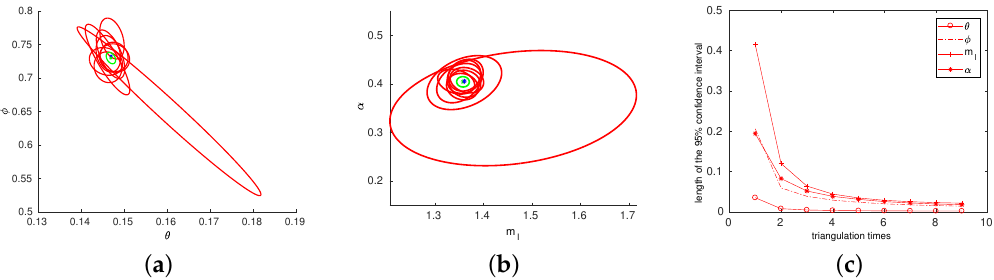
Figure 9. Uncertainty fusion by multiple triangulations. ( a ) Red ellipses denote uncertainty estimated by each triangulation, the green ellipse denotes the final uncertainty after fusion. The blue “*” represents the ground truth of d and the green “*” represents the finally estimated d . ( b ) The same case for m as described in ( a ). ( c ) The 95% confidence interval length of θ , φ , m l and α decrease along with more and more